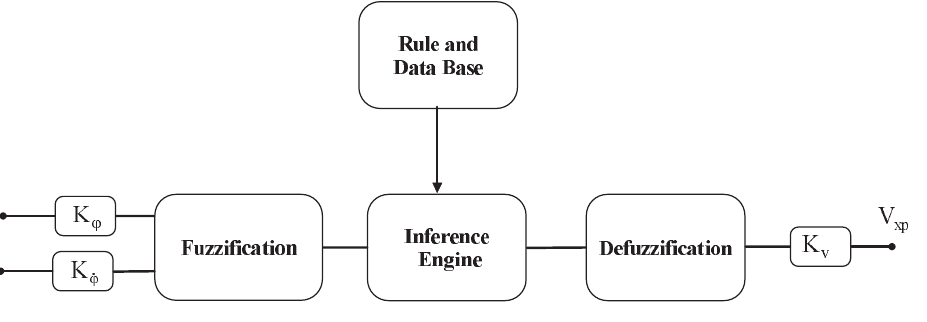
Fig. 10. Fuzzy logic control (FLC)